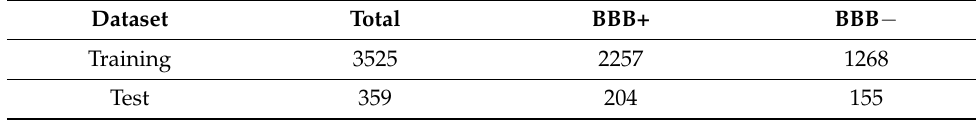
Table 7. Number of molecules in the training and test sets also grouped by class. Dataset